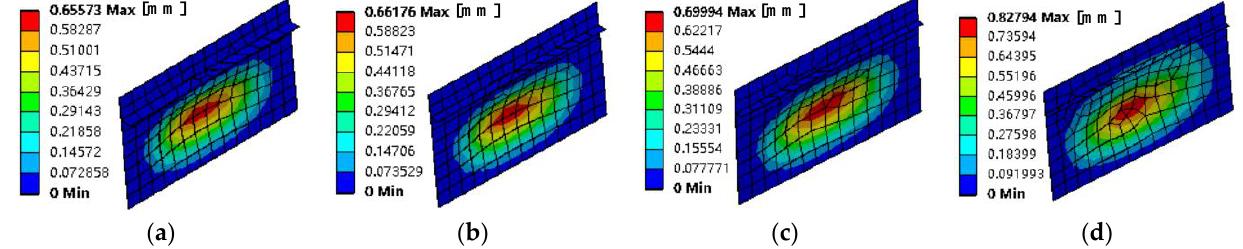
Figure 10. Response diagram of variable width stiffened plate. ( a ) 50 mm wide. ( b ) 40 mm wide. ( c ) 30 mm wide. ( d ) 20 mm wide.